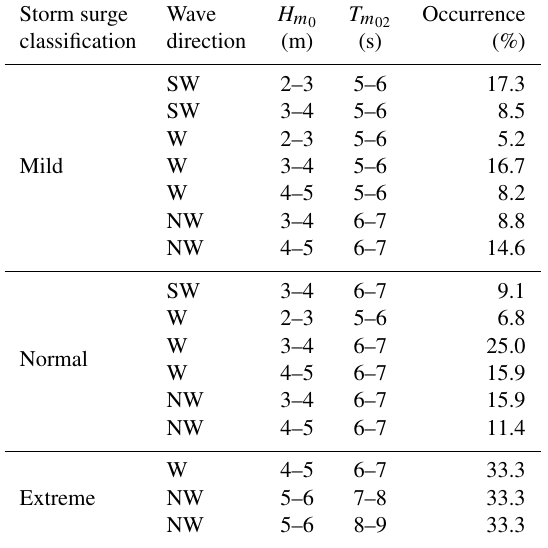
Table 1. Characteristics of the local storm surge climate based on wave buoy measurements. Occurrence relates to the percentage of occurrence of storms with those characteristics over the population of mild, storm or extreme